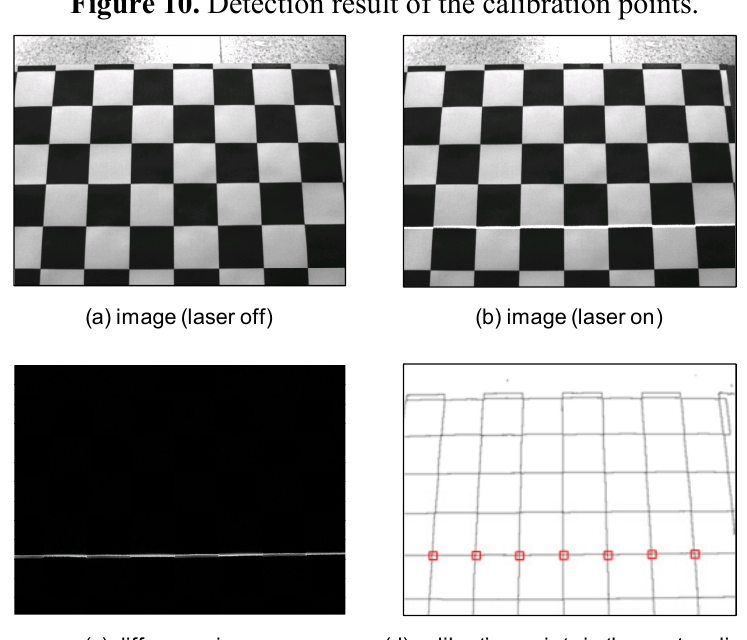
Figure 10. Detection result of the calibration